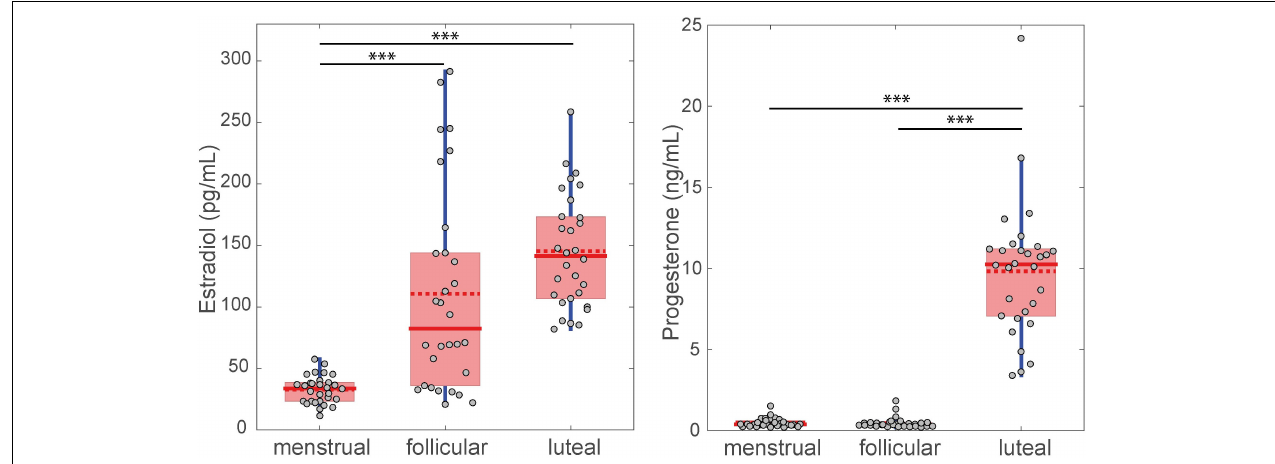
FIGURE 3 | Difference between FSS levels for the three menstrual cycle phases. The filled red line in the boxplot represents the median and the dotted red line represents the mean. ∗∗∗ p <